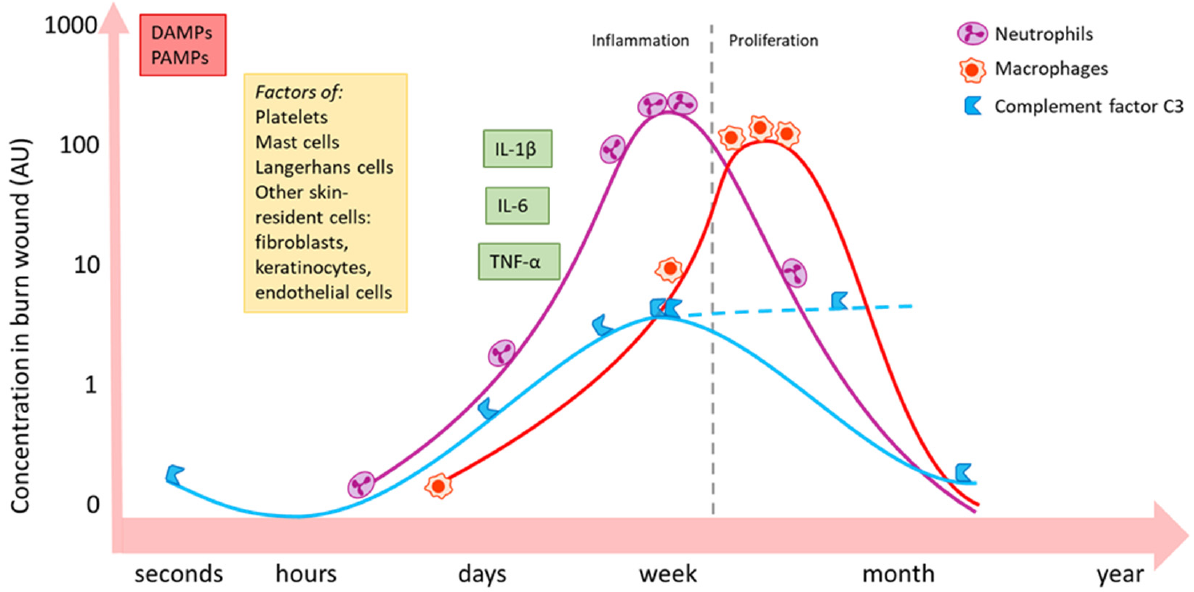
Figure 2. Schematic summary of the local activity of some important inflammatory mediators and immune cell types post-burn [10,25,26]. Burn induces an immediate increase in local concentration of DAMPs and PAMPs via necrotic tissue and infiltrating pathogens. Skin-resident (immune) cells become active and release inflammatory mediators and could change, for example, their expression of certain receptors. Neutrophils (purple) massively migrate into the wound bed during the inflammatory phase and follow a similar pattern as complement factor C3 (blue). C3 levels might continuously increase in later phases (dashed line). Macrophages (red) peak in the later proliferation phase. The influx of immune cells is paralleled by an increase in inflammatory cytokines and growth factors, such as IL-1 β , IL-6 and TNF- α . Local persistence of inflammation might continue up to weeks post-burn. DAMPs: damage-associated molecular patterns; PAMPs: pathogen-associated molecular patterns; IL: interleukin; TNF: tumour necrosis factor.